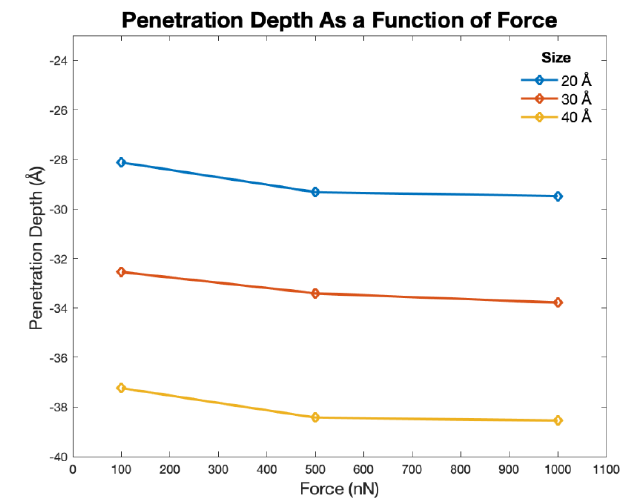
ff erent indenter size and